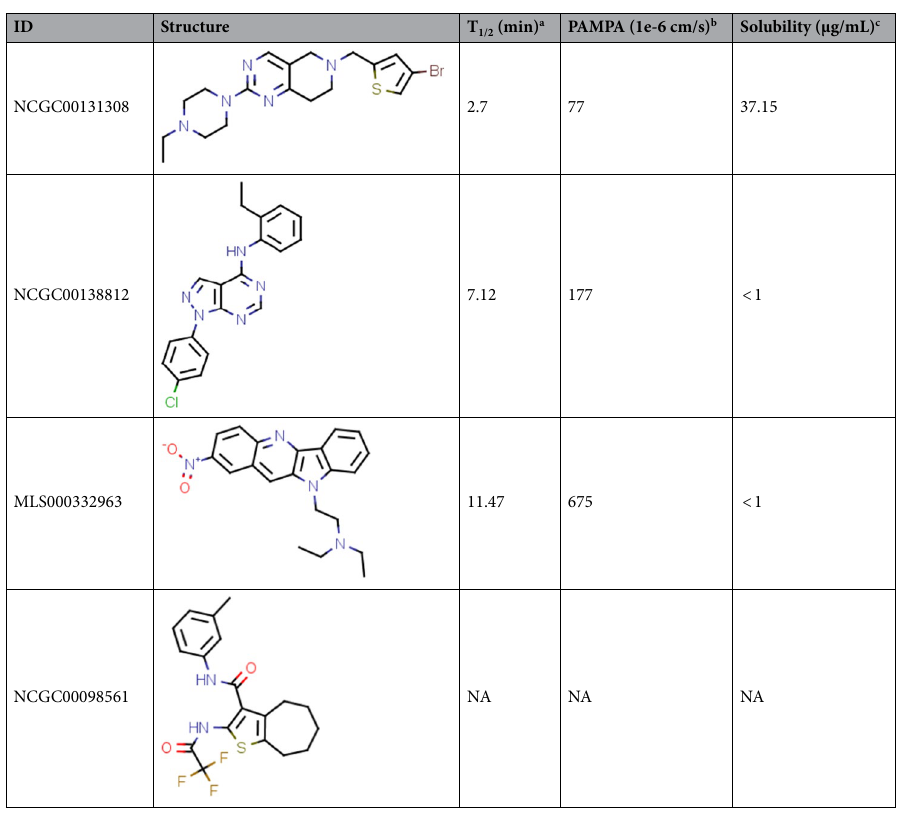
Table 1. Structures and in vitro physicochemical properties of four selected compounds, NCGC00131308, NCGC00138812, MLS000332963 and NCGC0009856, with notable activity in immunoprecipitation assay. a T 1/2 : metabolic half-life measured in rat liver microsome lysates reported in minutes (minimum detectable half-life of 1 min). b Parallel artificial membrane permeation assay (PAMPA) is reported as a metric of the passive permeability of the compounds. c Solubility–pION µSOL assay for kinetic aqueous solubility determination, pH